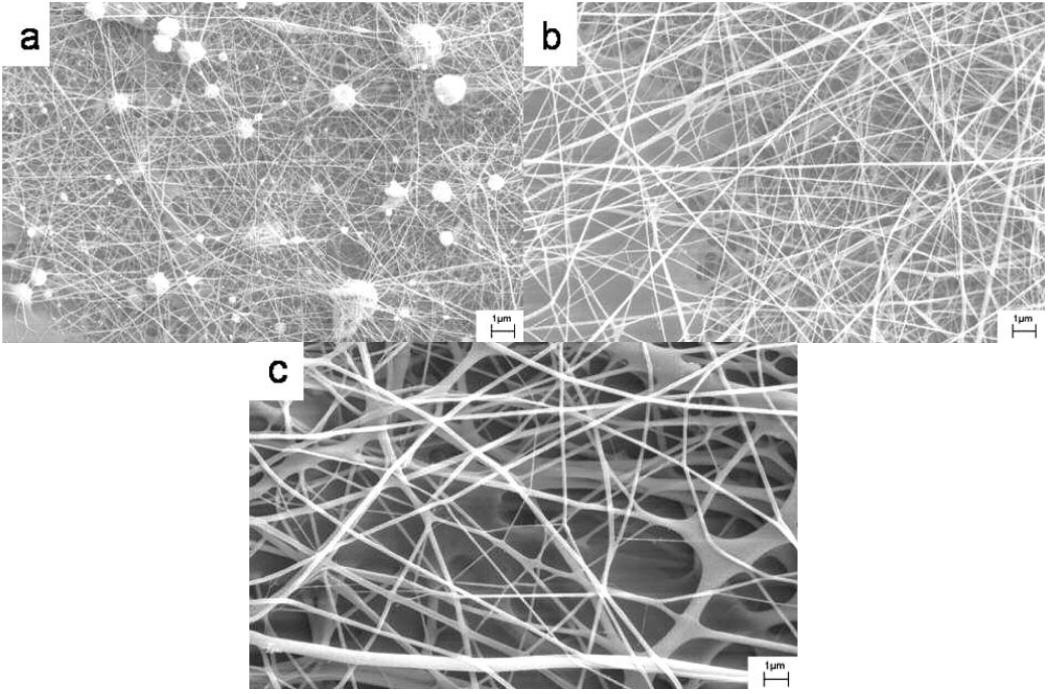
Figure 4. SEM images of HMW chitosan/HMW PEO blend fibers: (a) 1.33 wt% HMW chitosan/HMW PEO (90:10); (b) 1.6 wt% HMW chitosan/HMW PEO (75:25); (c) 2.00 wt% HMW chitosan/HMW PEO (50:50) (Adapted from [52]).